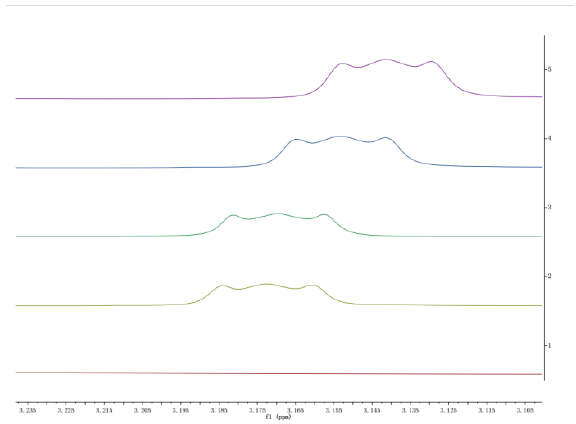
Figure 23. A part of a larger view of Figure